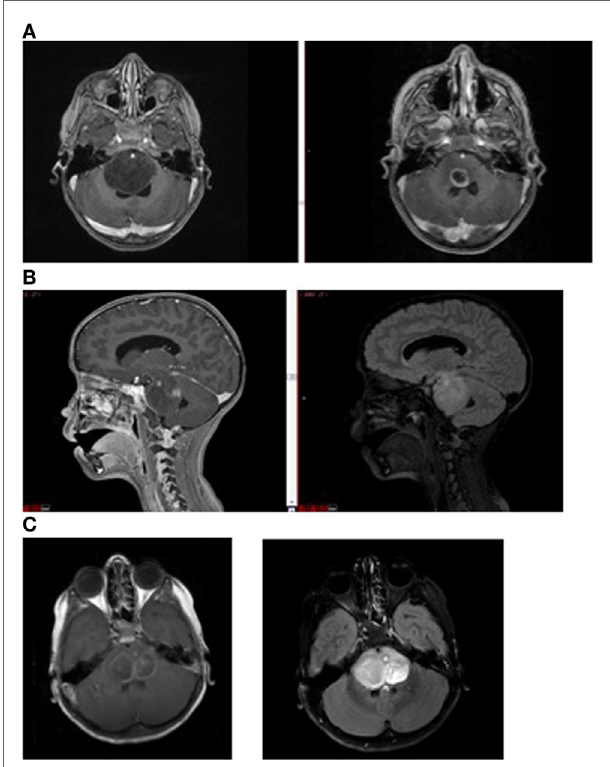
FiGURe 3 | Magnetic resonance imaging demonstrating (a) non-enhancing tumor at diagnosis (left) and enhancement (right) following radiation therapy; (B) tumor necrosis (enhancement at diagnosis, left) and FLAIR image (right) showing extent of tumor beyond area of enhancement, and (C) intratumoral cysts. Areas of contrast enhancement do not represent tumor burden in diffuse intrinsic pontine glioma and do not ensure adequate drug